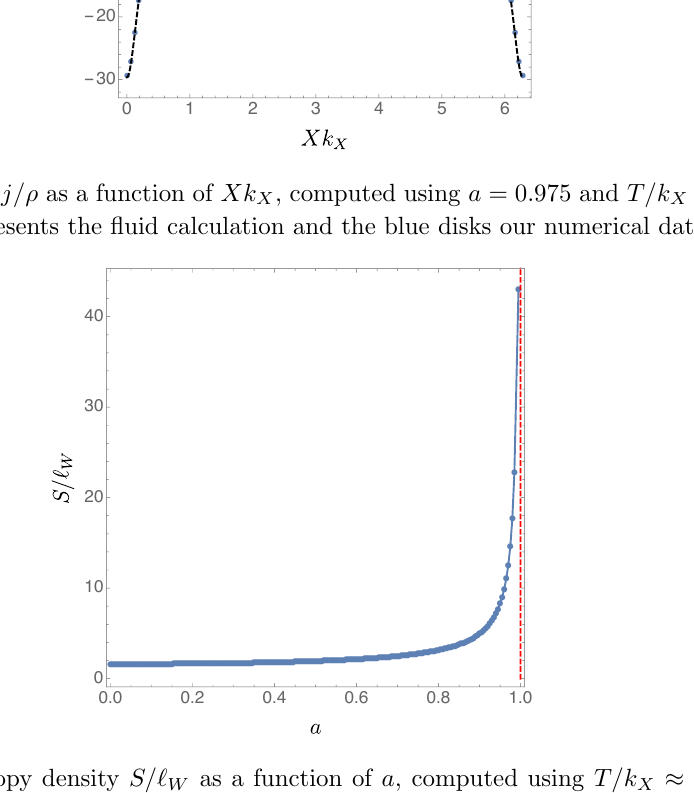
Figure 24 . The entropy density S=‘ W as a function of a , computed using T=k X (cid:25) 0 : 2387. The vertical dashed red line marks a = 1, where a boundary ergoregion forms. (This is very close to a max and our numerics cannot distinguish